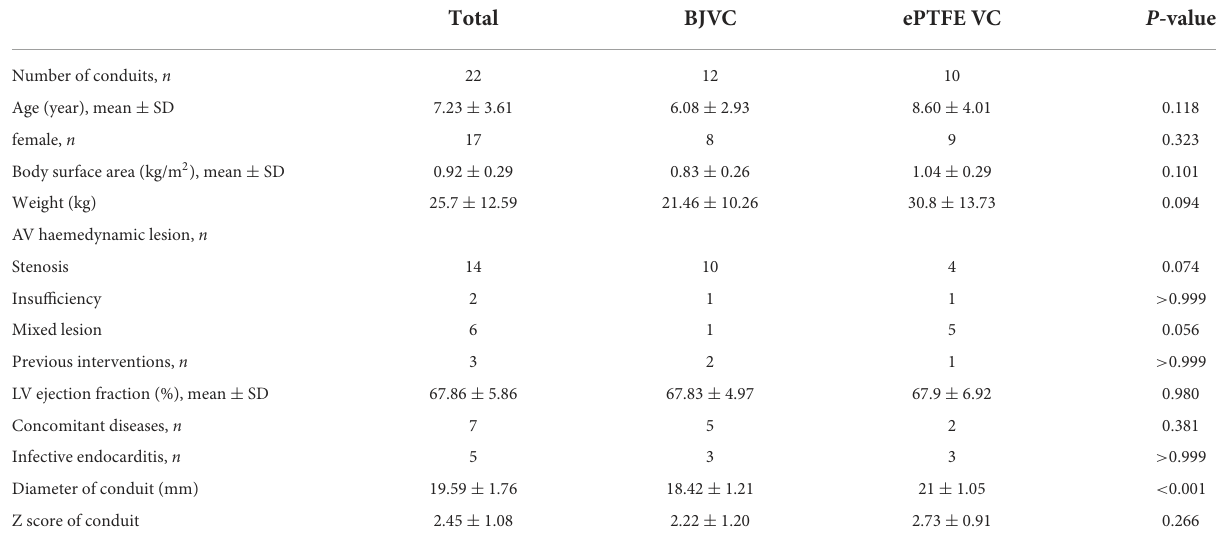
TABLE 1 Basic clinical character of the patients with Ross procedure.